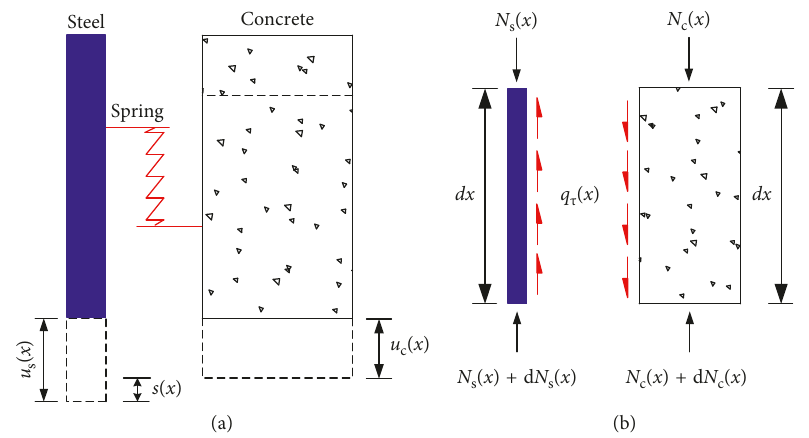
Figure 4: Relative slip and load distribution of the microbody. (a) Relative slip model. (b)